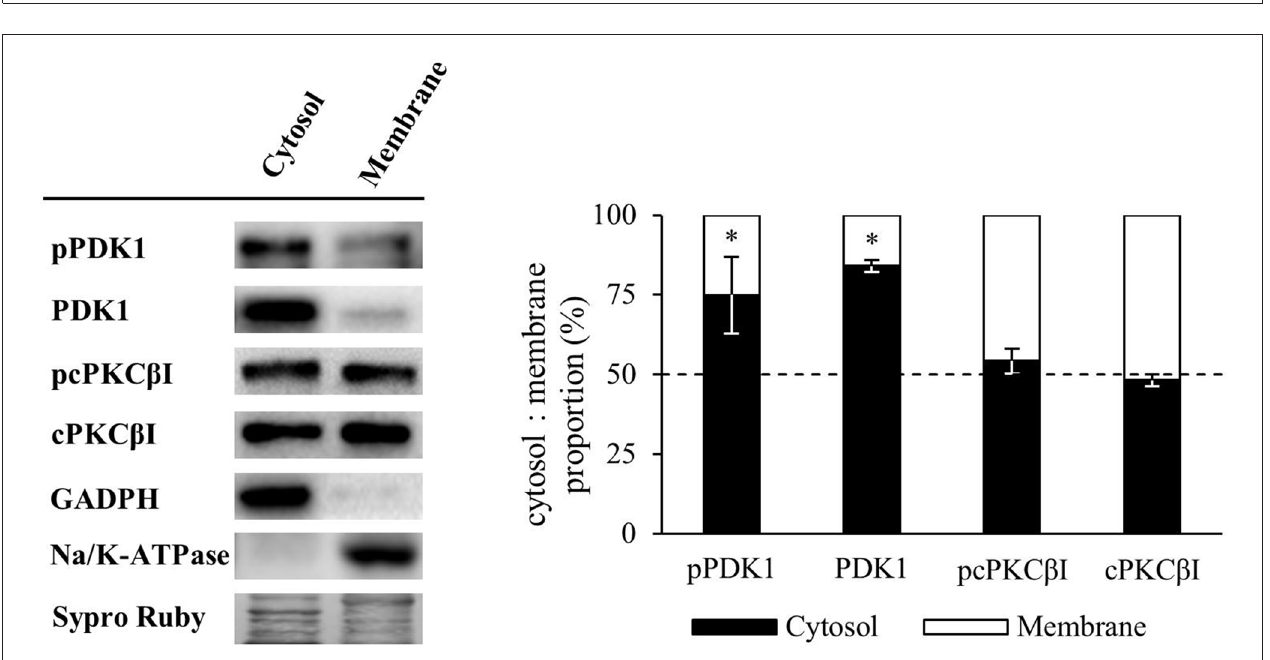
FIGURE 4 | Membrane and cytosol distribution of PDK1 and cPKC β I in basal conditions. Western Blot analysis of the distribution of PDK1 and cPKC β I in membrane and cytosol fraction of skeletal muscle. Results showed that in basal conditions, pPDK1 and PDK1 were found predominantly in the cytosol fraction while pcPKC β I and cPKC β I were present similarly in both cytosol and membrane fractions. Moreover, glyceraldehyde 3-phosphate dehydrogenase (GAPDH) was found in the cytosol fraction and essentially undetectable in the membrane fraction. As expected, the membrane protein Na/K-ATPase was highly enriched in this cellular component, and undetectable in the cytosol fraction. Data are mean percentage ± SEM, ∗ p < 0.05 ( n = 5). Abbreviations: phosphoinositide-dependent kinase 1; pPDK1, phosphorylated phosphoinositide-dependent kinase 1; cPKC β I, conventional protein kinase C β I; pPKC β I, phosphorylated conventional protein kinase C β I.